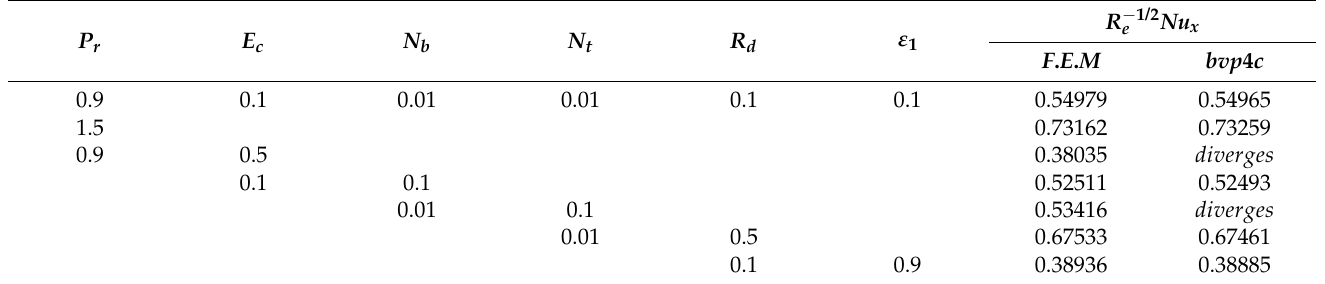
Table 4. List the numerical values for the the local Nusselt number (excluding the Reynolds number) using M = 0.5, λ = 0.1, F r = 0.1, S c = 1.5, E 1 = 0.05, β = 0.5, ε 2 = 0.1, γ = 0.25.